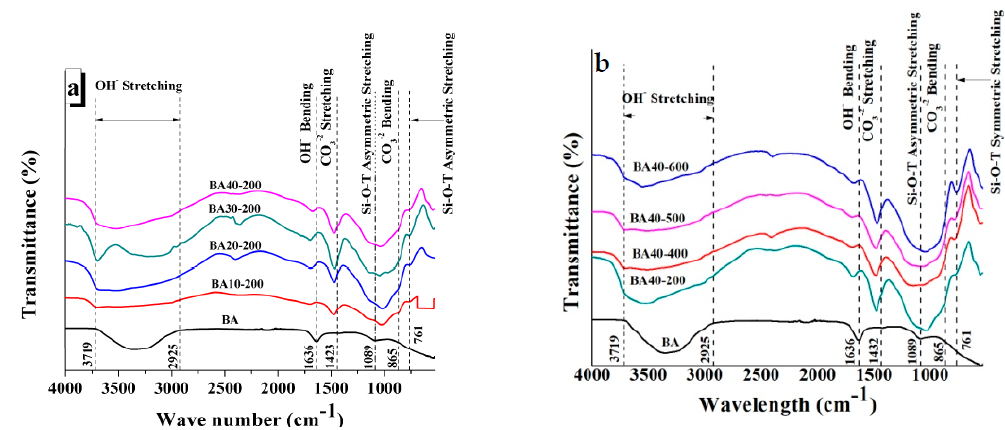
Figure 5. FTIR analysis of BA and TGPFs of ( a ) different compositions cured at 200 °C and ( b ) 40% BA composition cured at different temperatures.